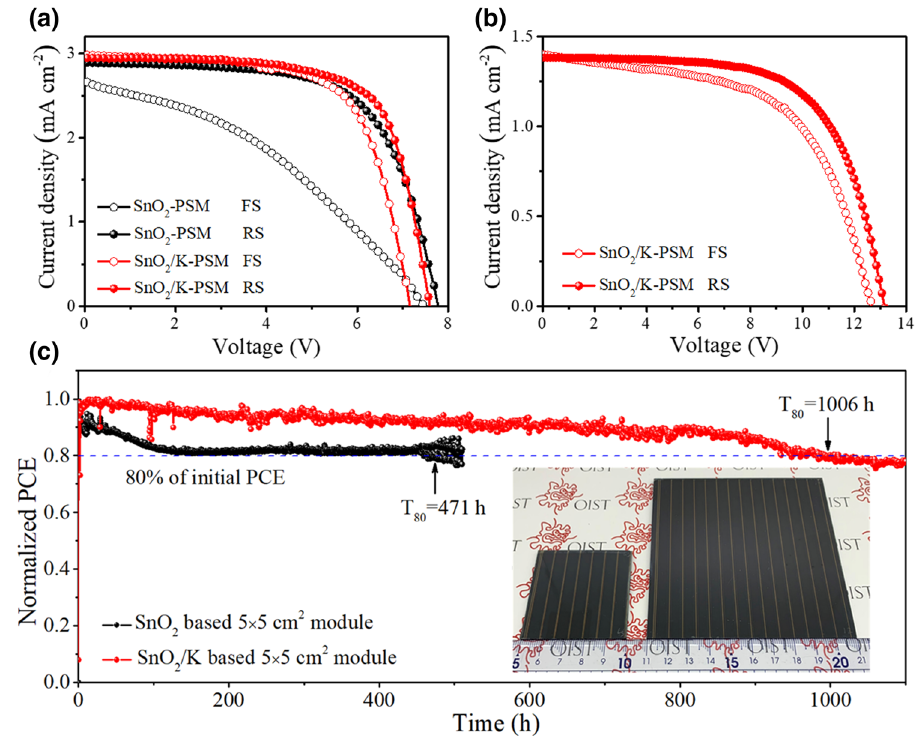
Fig. 5 Performance of Perovskite Solar Cell Modules. a J-V curves of 5 × 5 cm 2 PSMs based on SnO 2 with/without KMnO 4 passivation under forward and reverse scan. b J-V curves of 10 × 10 cm 2 PSMs based on SnO 2 /K under forward and reverse scan. c Operational stability of 5 × 5 cm 2 PSMs based on SnO 2 /K with encapsulation under a steady applied voltage and constant illumination (AM 1.5G, 100 mW cm −2 ), inset: photographs of 5 × 5 cm 2 and 10 × 10 cm 2